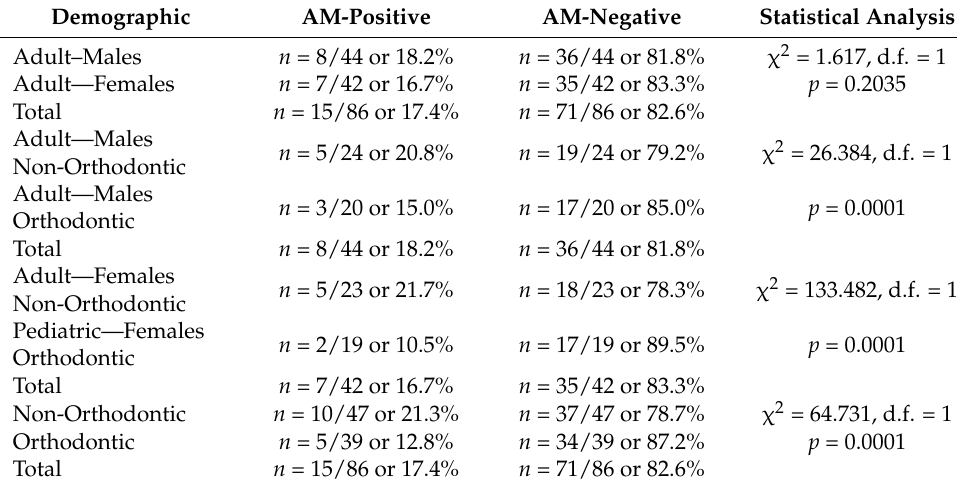
Table 5. Analysis of AM-positive and AM-negative adult